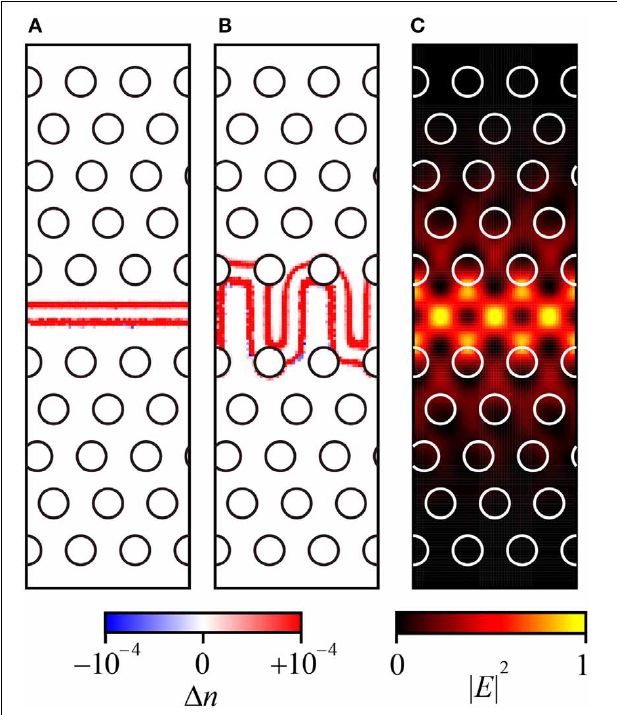
FIGURE 4 | (A,B) Index change of Si in device #1 with linear junction and #2 with interleaved junction ( w y = 600nm), respectively, and (C) . Waveguide mode intensity in unit cell model II in Figure 2